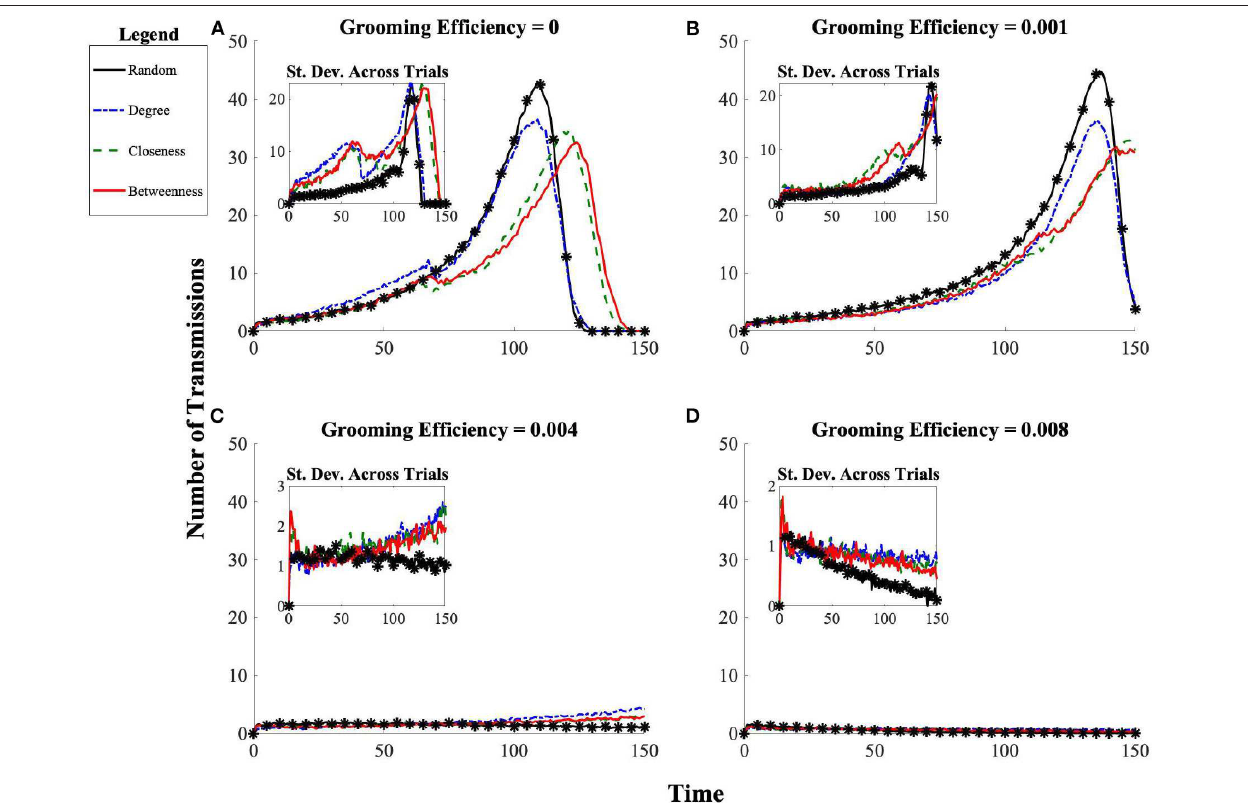
FIGURE 4 | Progression of number of ectoparasite transmission events over time for each affiliation strategy (random, betweenness, closeness, and degree) across grooming efficiencies (A) g = 0, (B) g = 0.001, (C) g = 0.004, (D) g = 0.008. The initial introduction of ectoparasites to the network occurs at t = 0. The standard deviation across 100 simulated trials is shown in the inset. In the case of maximal outbreak (top panels), the number of transmissions per time unit increases until each individual has reached its maximal ectoparasite load and ectoparasites can no longer be transmitted, at which point the transmission rate drops to